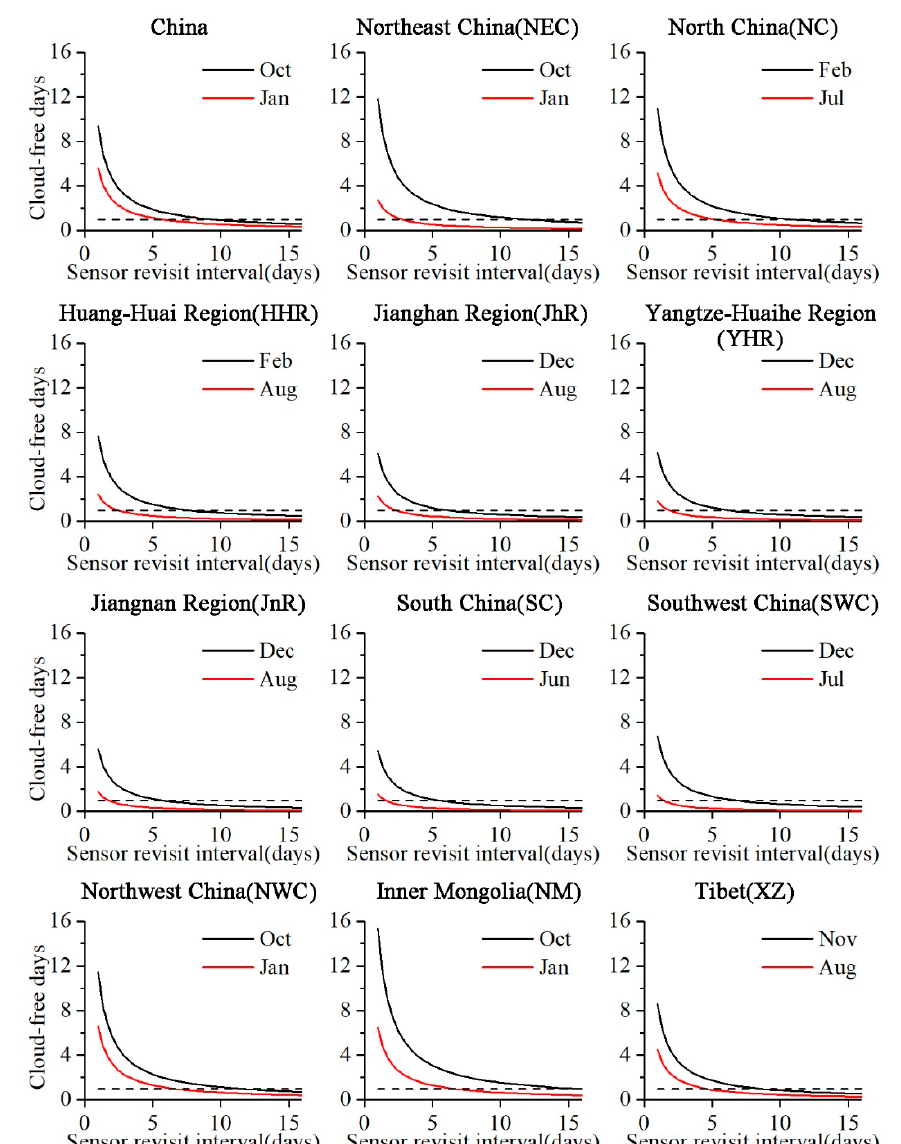
Figure 6. The number of days to acquire cloud-free imagery per month with different revisit frequencies throughout the country and regions. The dashed line indicates that the number of cloud-free days is 1.